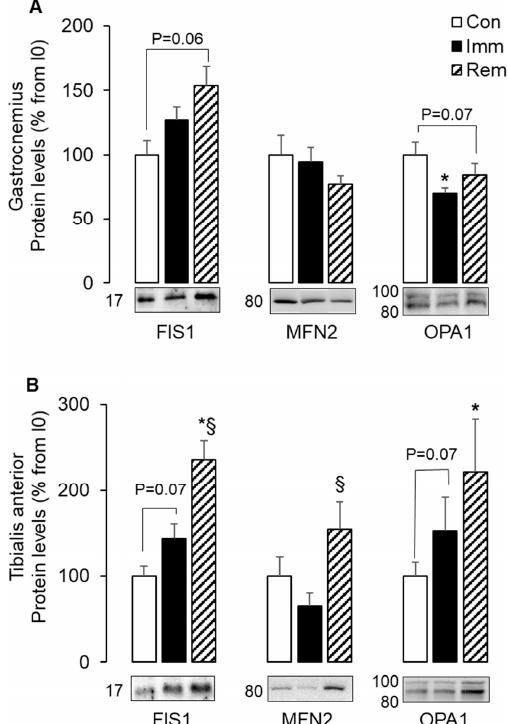
Figure 2. A concomitant increase of mitochondria fusion and fission markers during TA remobilization. Protein levels for FIS1, MFN2, and OPA1 were assessed by Western blots in the GA ( A ) and the TA ( B ), quantified and normalized using Ponceau red staining for uneven loading. Several isoforms of OPA1 tune mitochondrial adaptations. Thus, the 2 isoforms detected here were quantified together. Representative Western blots are shown below each graph, and molecular weights are given in kDa. Data were expressed as % from the Con group. Statistical differences were assessed by ANOVA, as described in Materials and Methods. * p < 0.05 vs. Con, § p < 0.05 vs. Imm; Con, non-immobilized rats; Imm, immobilized; Rem, remobilized.